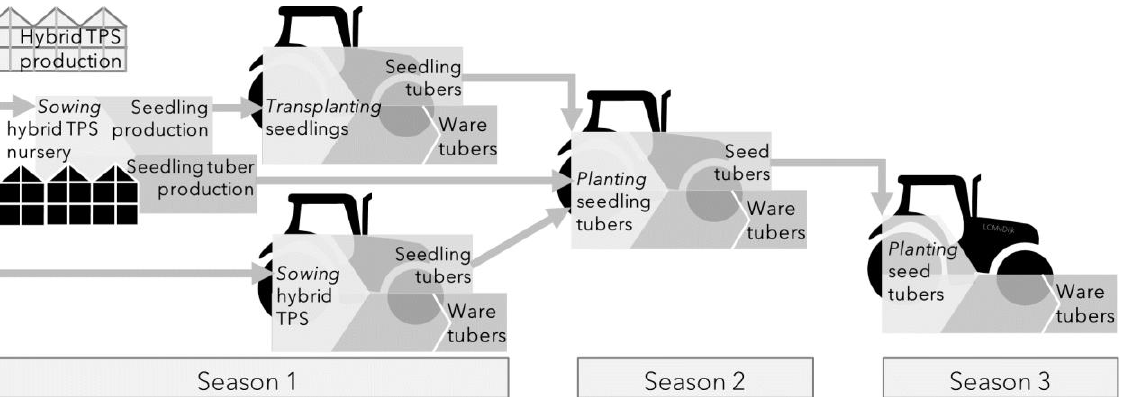
Figure 3. Routes to a ware crop, from van Dijk et al. 2021 [53]. In one, two or three seasons ware tubers can be produced. Transplanted seedlings were investigated by Van Dijk et al. [53,54,55]. Seed- ling tubers for ware production were investigated by Stockem et al., 2020